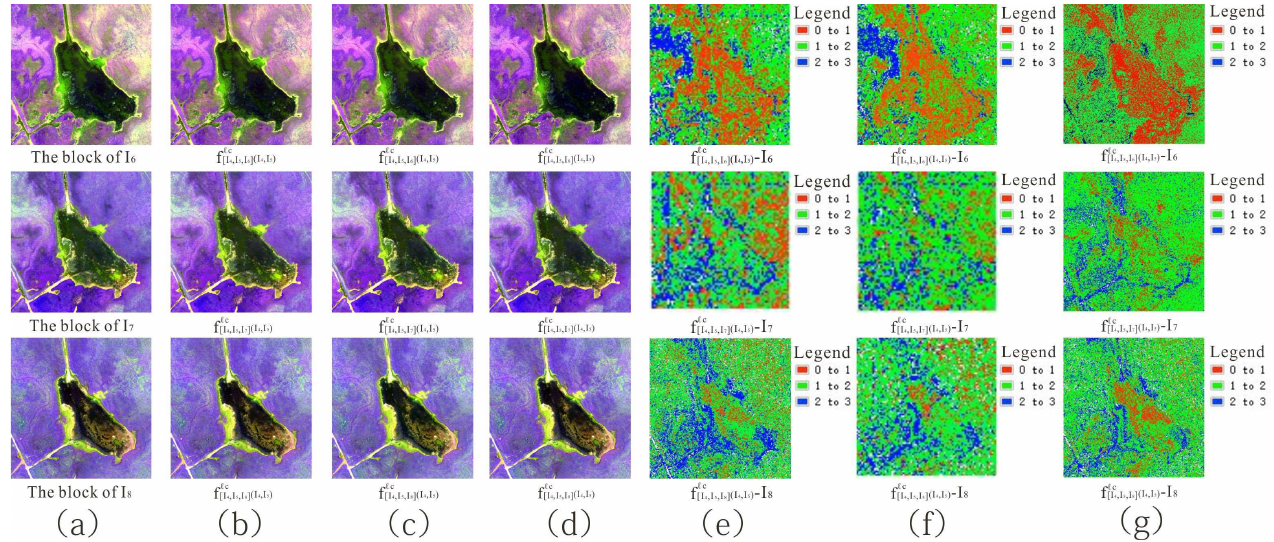
Figure 15. ( a ) Initial image ( b – d ) visual effect and ( e – g ) pixel error between block interpolated results and reference block using stacks of 1 × 1, 2 × 2, and 3 × 3 convolution layers.